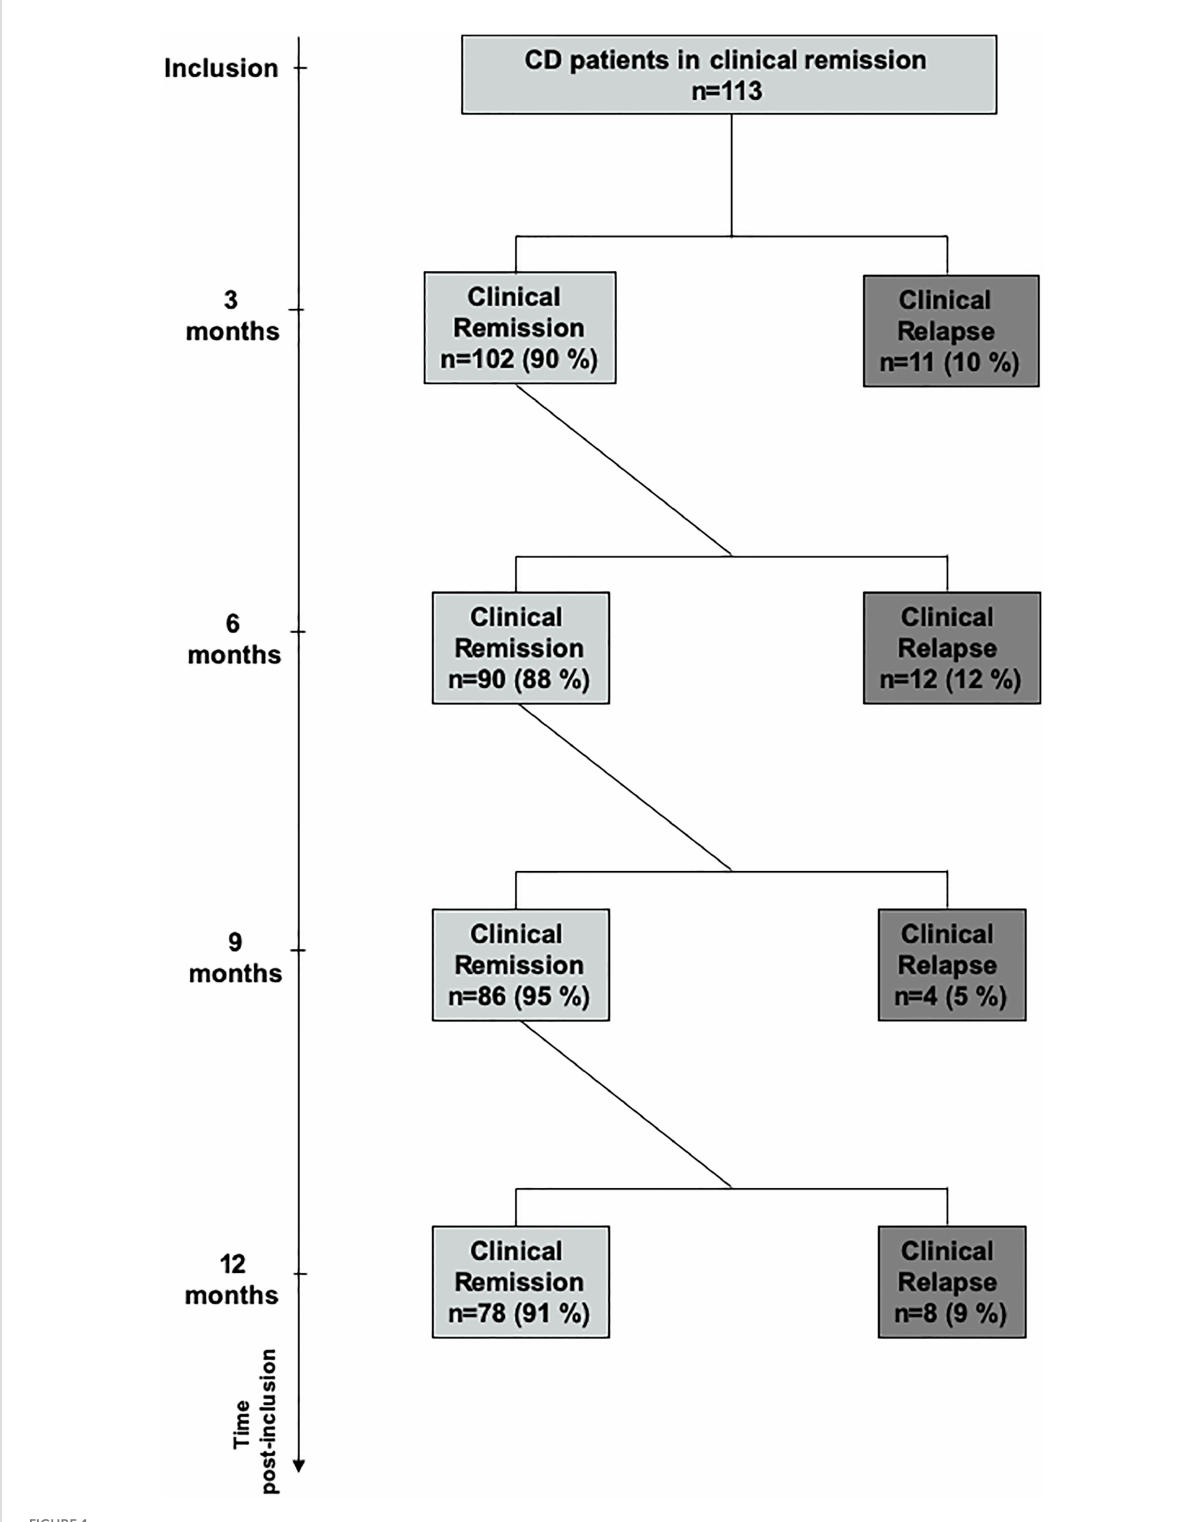
FIGURE 1 Flow chart of the cohort of Crohn ’ s disease